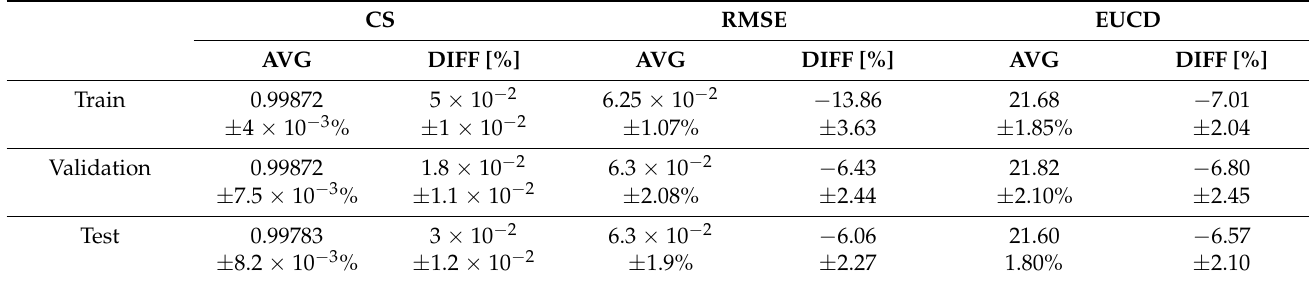
Table 4. Statistical comparison between ConvLSTM-SA model and reference ConvLSTM model.